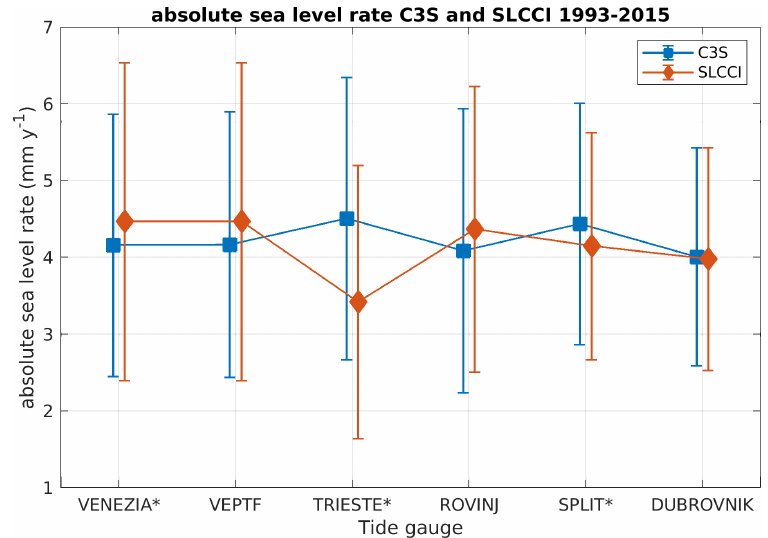
Figure 7. Pooled means and standard deviations of altimetry absolute sea level change rates associated with six TG locations during 1993–2015 for C3S (blue) and SLCCI (orange) datasets. In SLCCI plot, the anomalous value of TRIESTE is clearly visible, indicating possible local misbehavior of SLCCI data in the northeastern-most part of the Adriatic